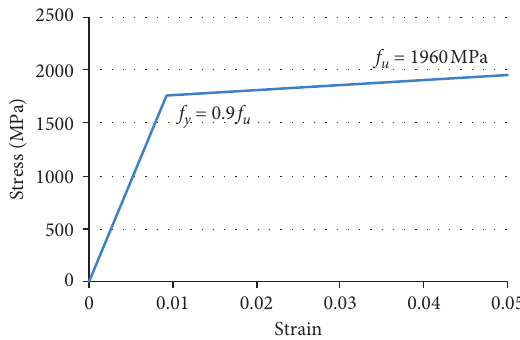
Figure 9: Stress-strain relation of steel braces under